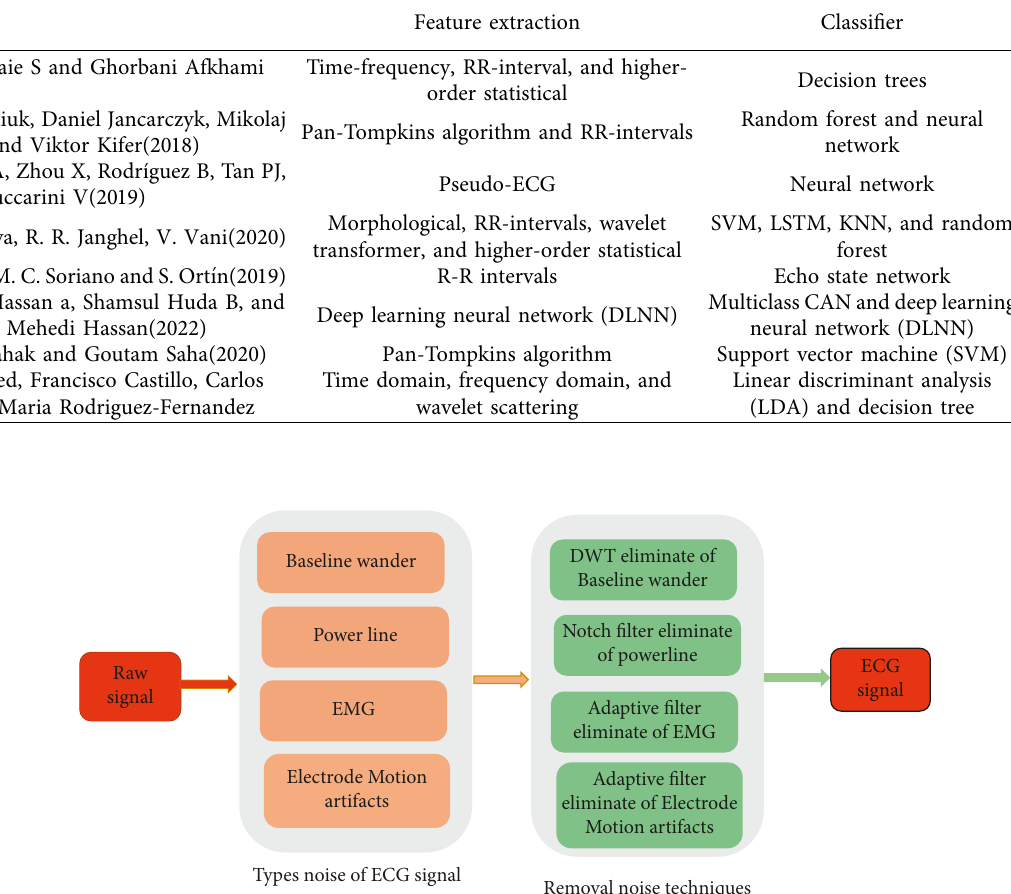
Figure 1: Block diagram of preprocessing of the ECG